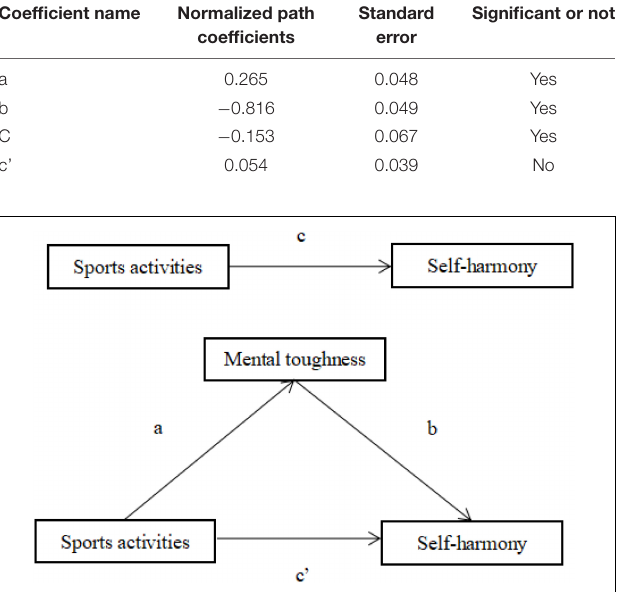
TABLE 11 | Mediating effect analysis results.